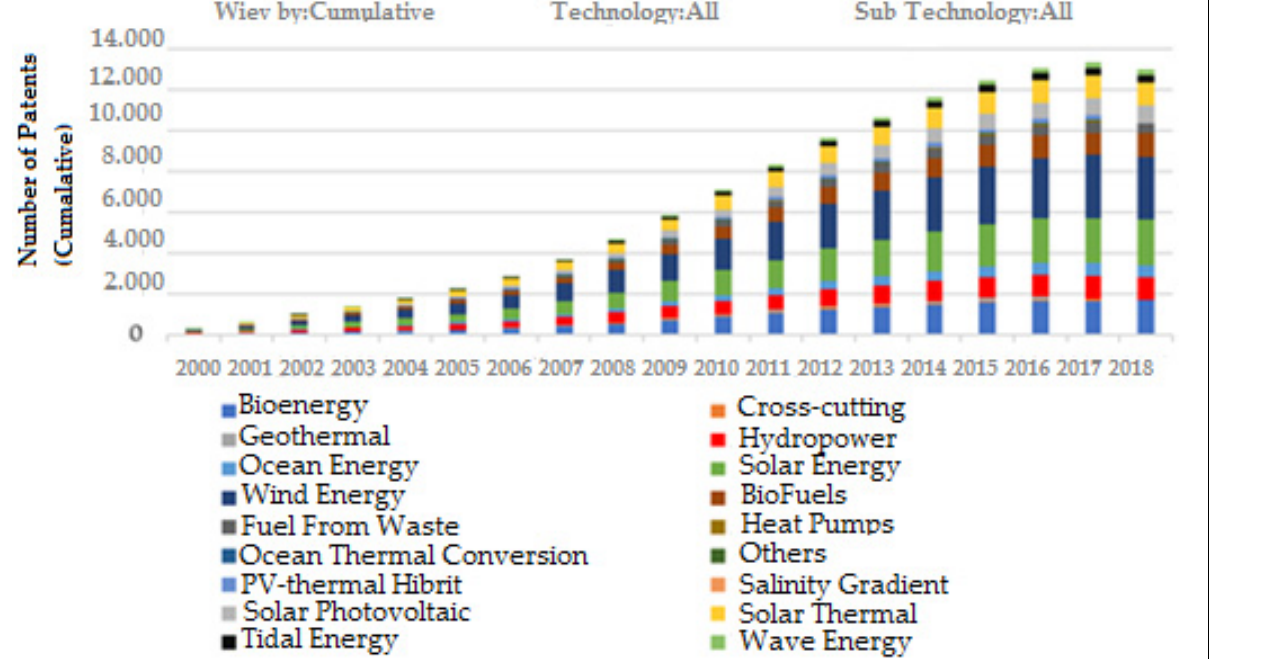
Table 1. An overview of the empirical research.